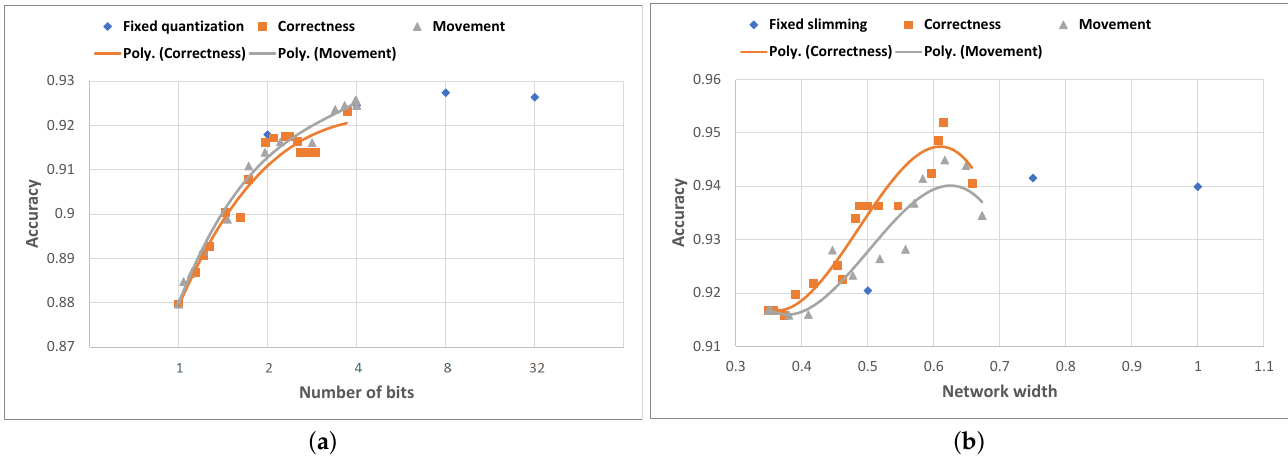
Figure 11. Results of the compression level selection algorithm based on LDA subspace projections. ( a ) Any-Precision. ( b )